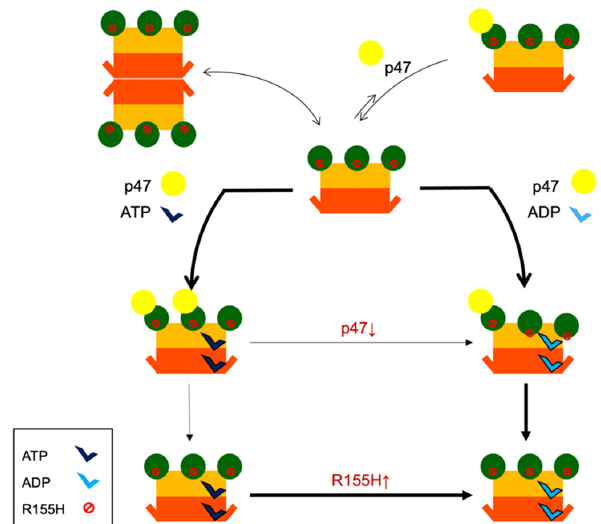
Figure 5. Proposed model for p47 binding to the disease-linked p97 R155H mutant. The NTD, D1, and D2 domains of the p97 R155H are colored green, orange, and orange-red. In the absence of nucleotides, p97 R155H can form a dodecamer and become inactive. p47 does not access the p97 R155H dodecamer in the absence of nucleotides. The p97 R155H hexamer does not stably bind to p47 in the absence of nucleotides. Once p97 R155H binds nucleotides, it stably interacts with p47. The p47 binding blocks the p97 R155H ATPase activity. Although the NTDs are all above the D1 ring plane in the presence of ADP, they adopt slightly different tilting angles and heights. However, in the presence of ATP, the NTDs are all in the same up configuration. The p47 interacts with the up-NTD, but not the down-NTD. Thicker lines indicate favor direction for reaction.